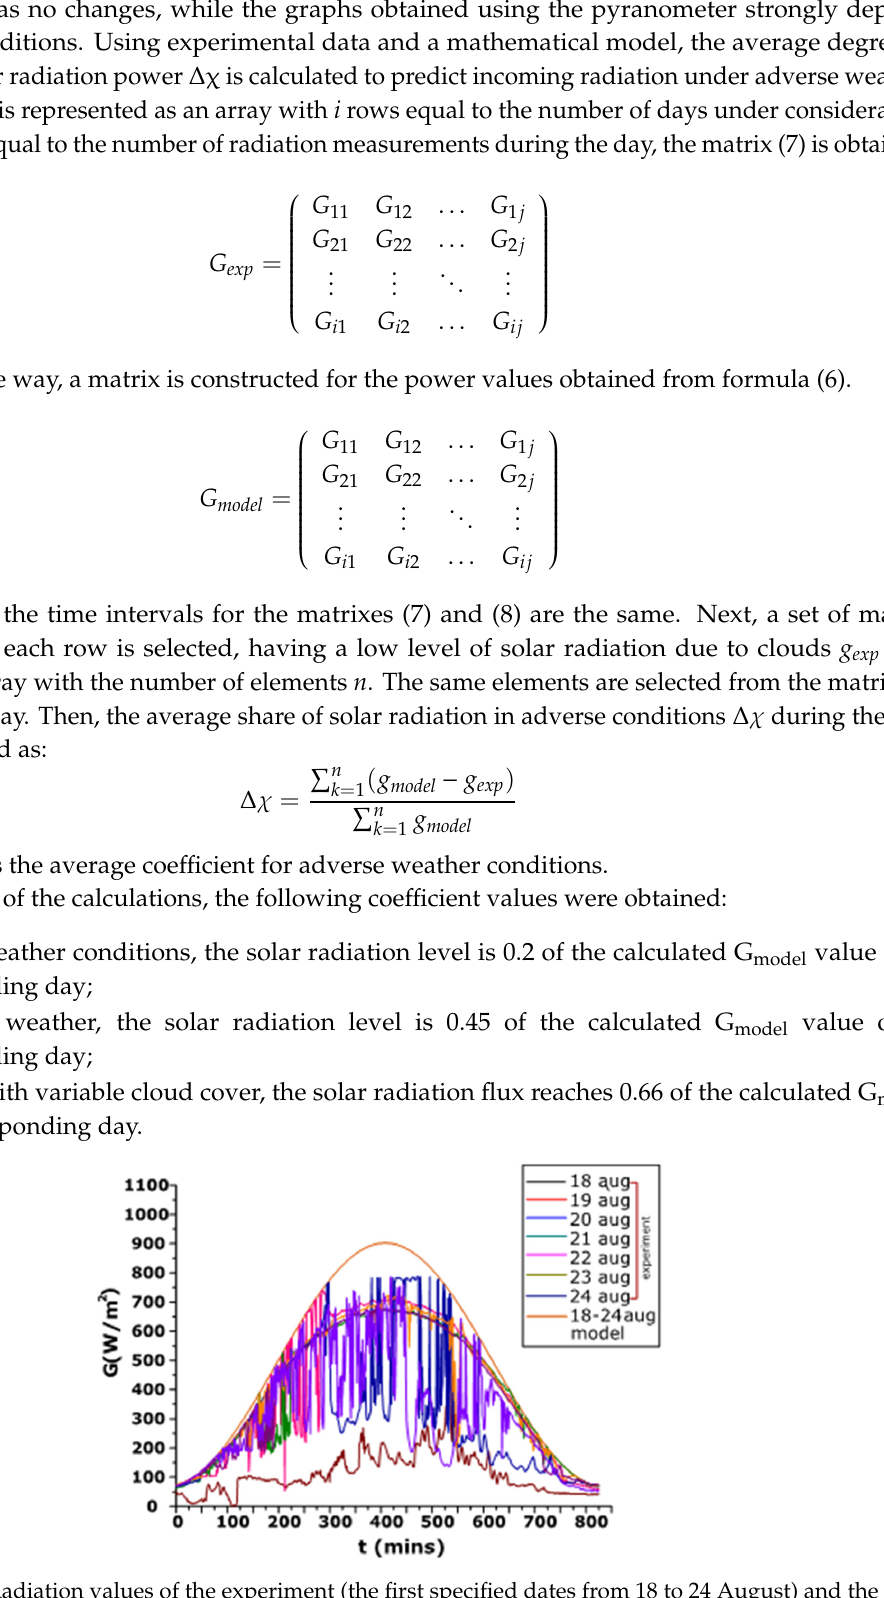
Figure 12. Radiation values of the experiment (the first specified dates from 18 to 24 August) and the model (the lower specified dates from 18 to 24 August). Using the obtained coefficients for various weather conditions, the radiation level was calculated for the 2019 year. Weather conditions for the year were obtained from an internet resource [61]. Figure 13 shows radiation graphs for the 2019 year under ideal conditions and taking into account coefficients for various weather conditions.